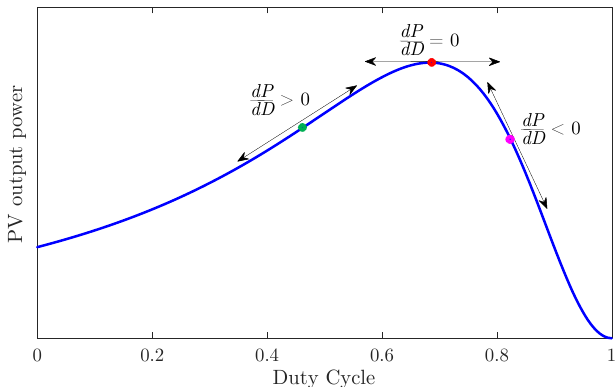
Figure 6. The hill-shaped curve of the P PV − D characteristic of the MPPT boost